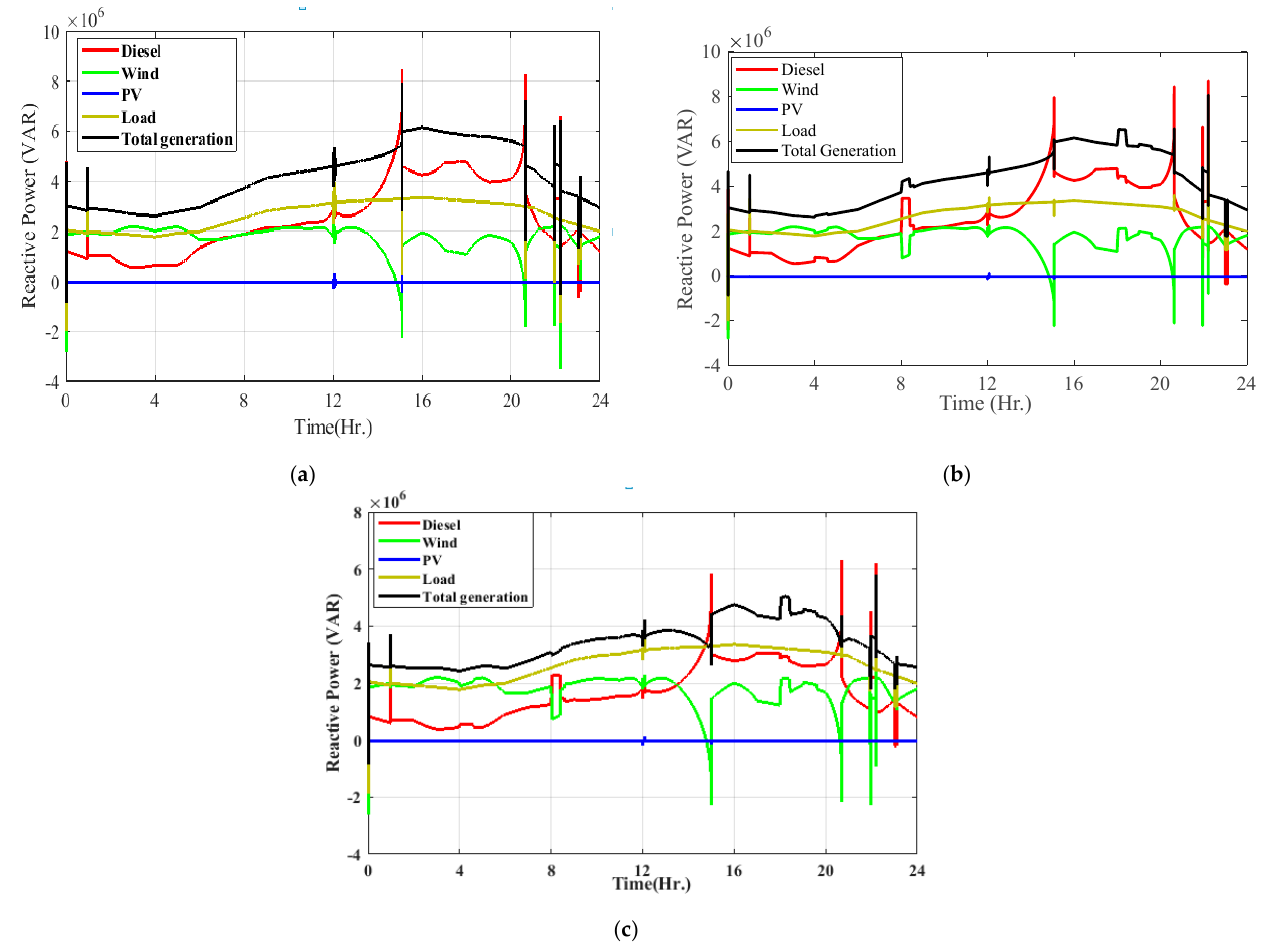
Figure 12. Total reactive power ( a ) without any compensations; ( b ) with V2G compensations; ( c ) with DSTATCOM and V2G compensations.